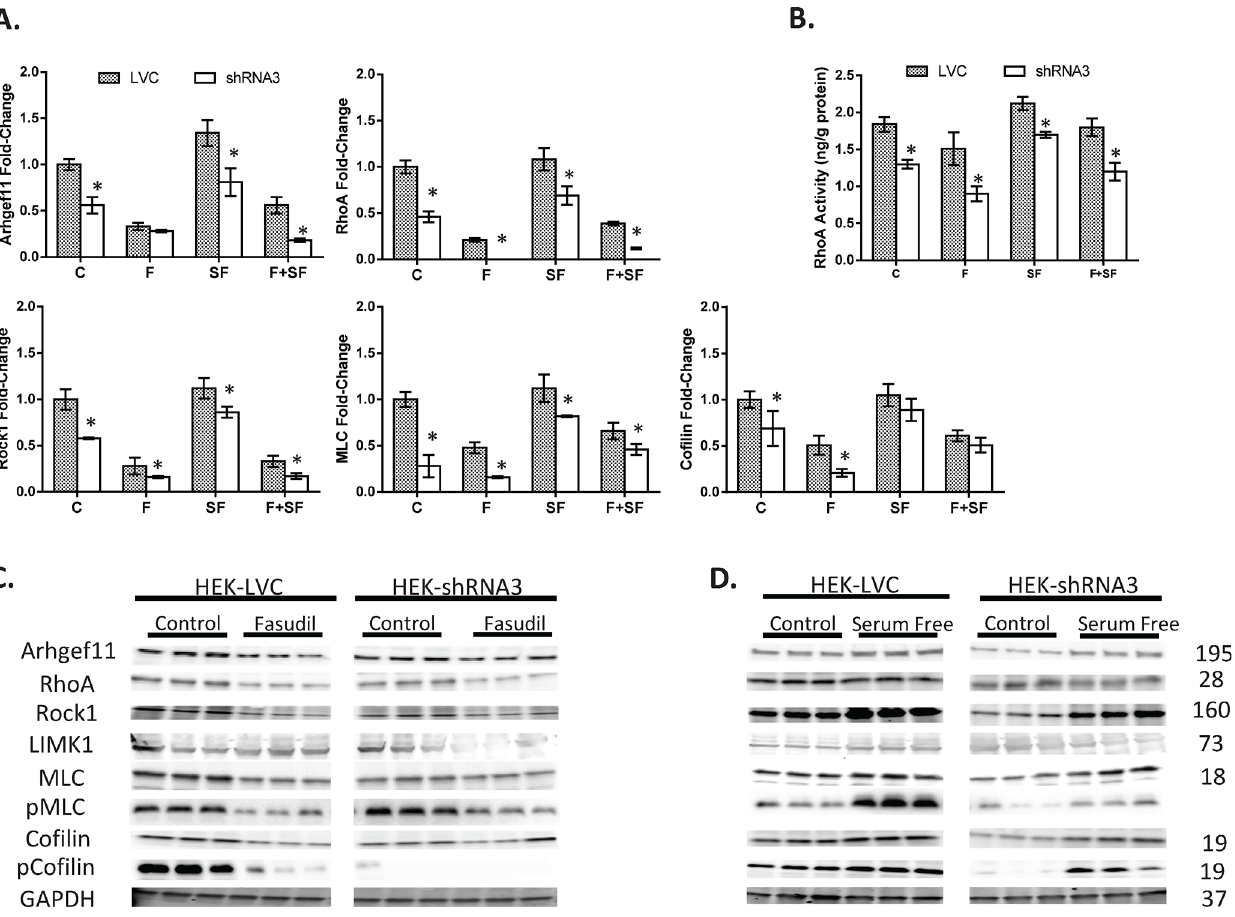
Fig 4. Analysis of the Rho-ROCK signaling pathway and RhoA activity in stably transduced Arhgef11 knockdown cell lines. Cell-culture experiments were performed under several experimental conditions: 1) control (DMEM medium); 2) fasudil (F) (10 μ g/ml) treated for 4hrs; 3) serum free (SF) for 24 hours, or 4) serum free for 24 hrs + fasudil treated for 4 hours (SF+F). ( A ) Real time PCR of Arhgef11 , RhoA , Rock1 , MLC and Cofilin of HEK293-shRNA3 compared to LVC (scrambled control). ( B ) RhoA activity between LVC and HEK293-shRNA3 under each experimental condition. ( C ) Western analysis of Rho-Rock pathway in LVC and HEK293-shRNA3 between control and fasudil treatment; and ( D ) Western analysis of Rho-Rock pathway in LVC and HEK293-shRNA3 between control and serum free conditions. Similar results were observed for LVC and NRK-shRNA3 for control versus fasudil ( S3 Fig ). n = 6 independent samples per group/treatment, * p < 0.05 versus LVC. Error bars are ±